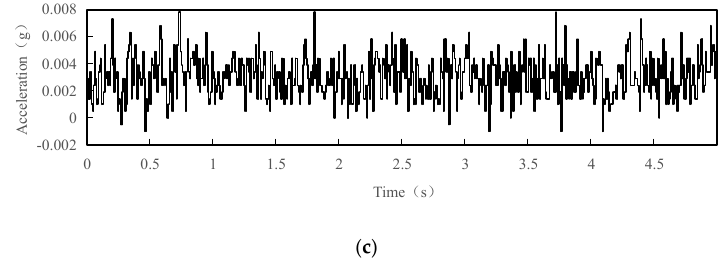
Figure 3. Acceleration time history curves with 5 s interval of the test point 1 under normal conditions: ( a ) acceleration time history curve in the X direction; ( b ) acceleration time history curve in the Y direction; ( c ) acceleration time history curve in the Z direction.